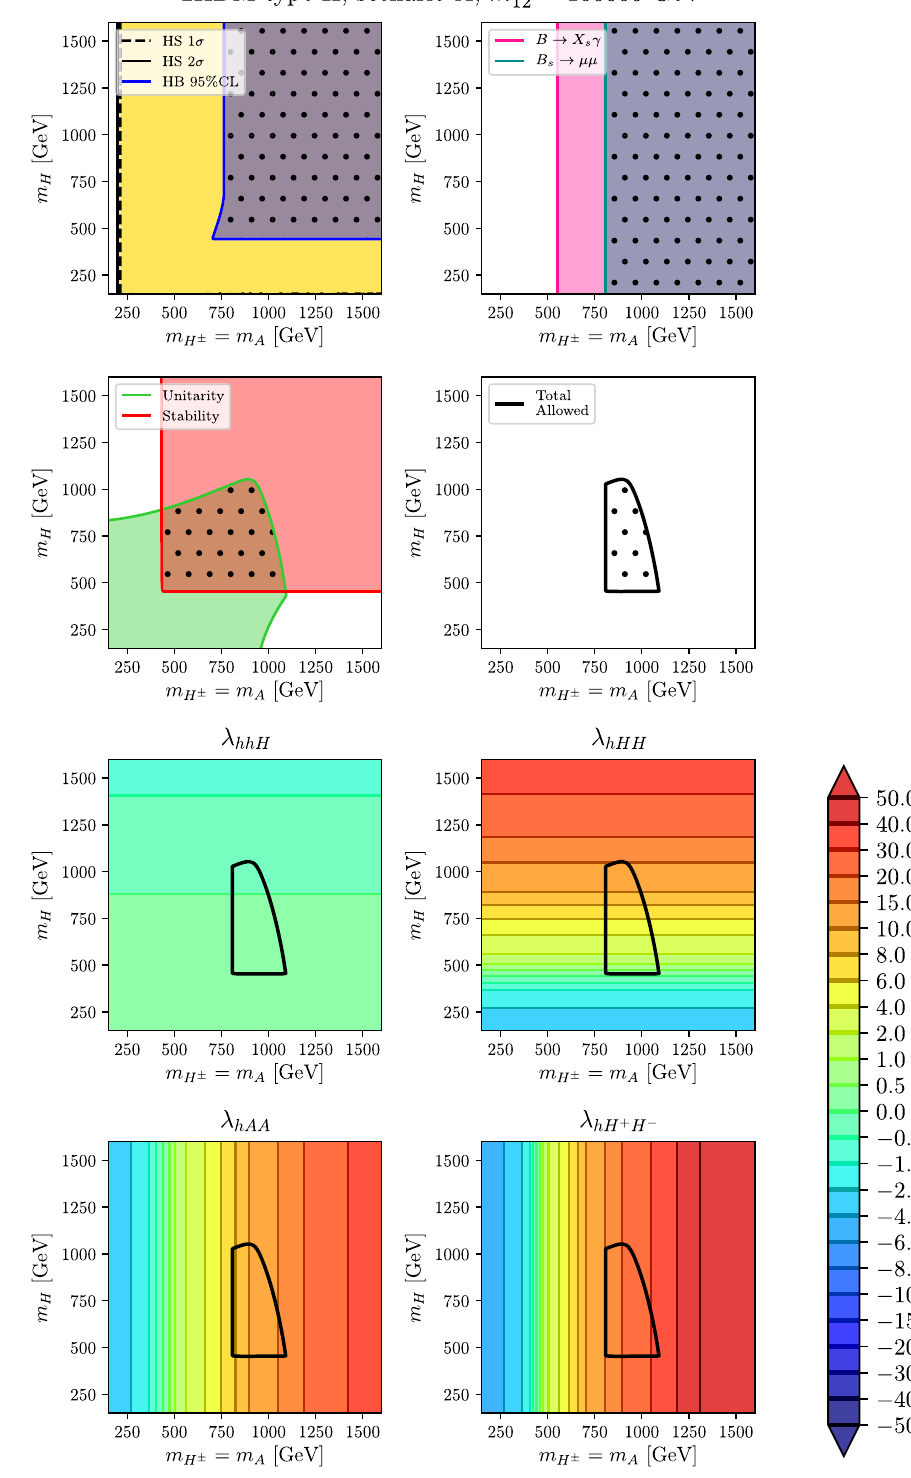
Fig. 18 Predictions for triple Higgs couplings in the 2HDM type II, scenario A, in the ( m H ± = m A , m H ) plane with c β − α = 0 . 05, = 100000 GeV 2 . Upper four plots: allowed tan β = 0 . 9 and m 2 12